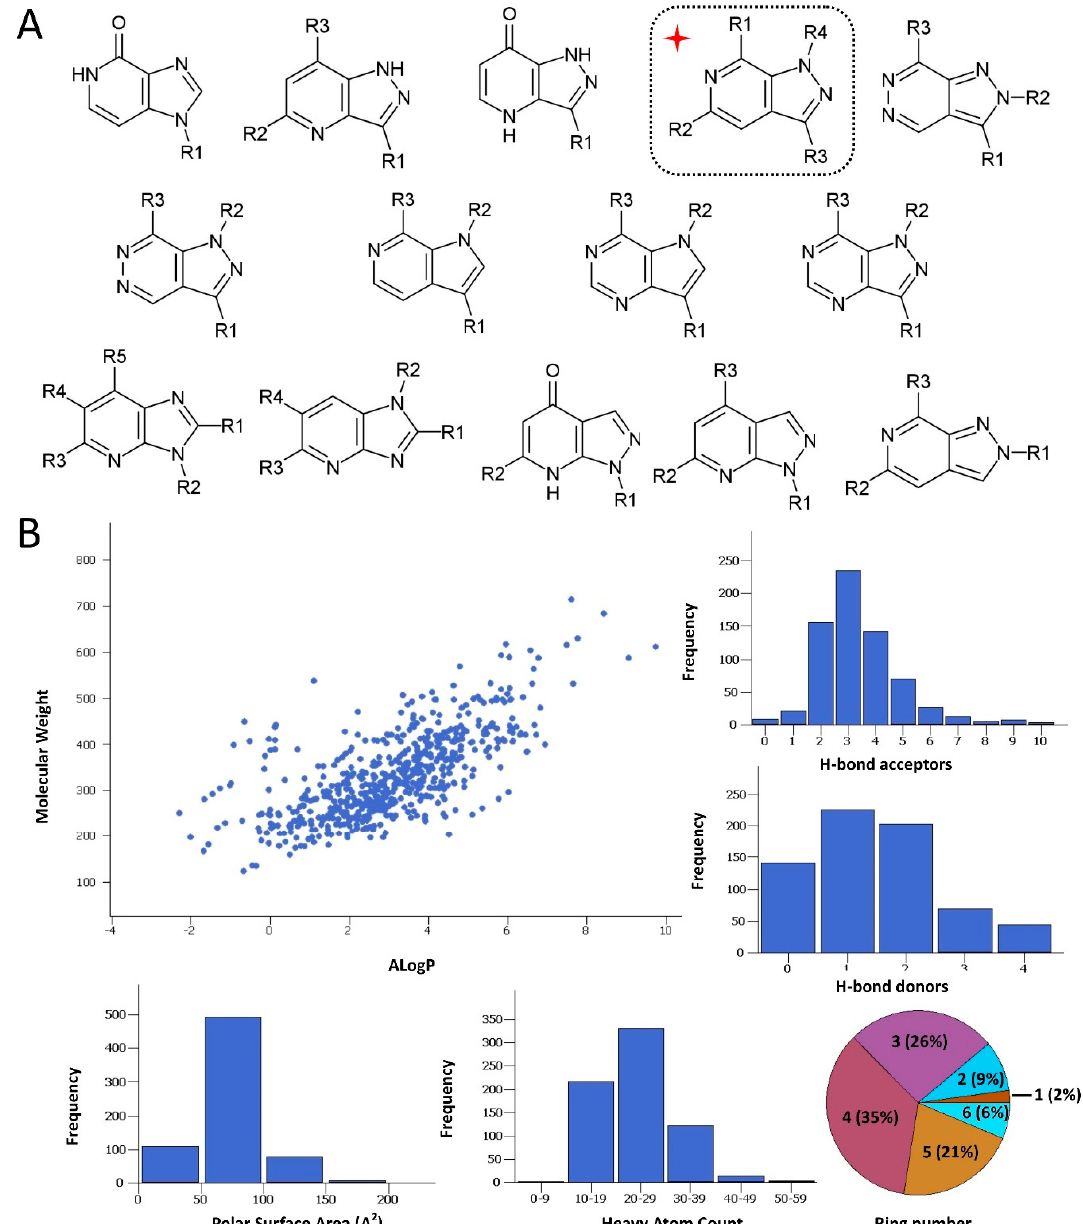
Figure 1. ( A ) The various substituted heteroaromatic scaffolds comprising the screened collection and the pyrazolo[3,4-c]pyridine core identified as a potent cystathionine β -synthase (CBS) inhibitor (inset denoted by a red cross). ( B ) Graphical evaluation of the collection drug-likeness in terms of key parameters related with the Rule-of-Five characteristics.